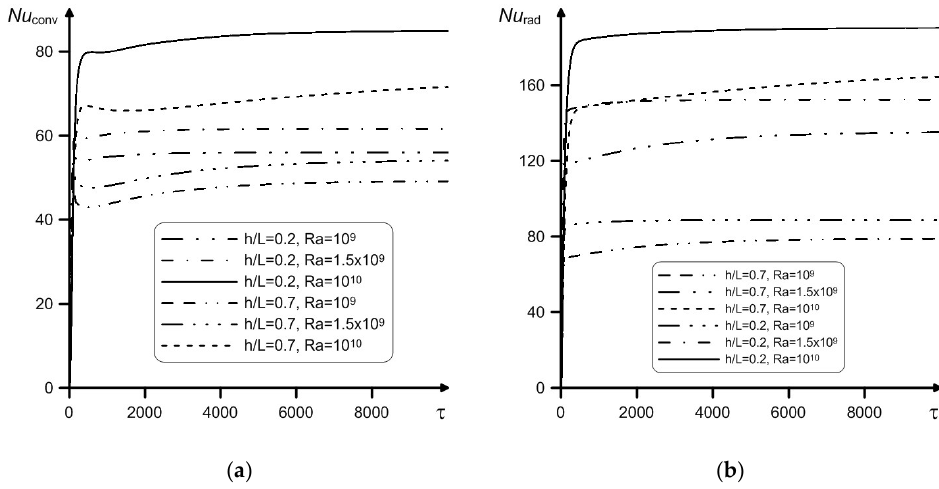
Figure 8. Dependences of the mean convective ( a ) and radiative ( b ) Nusselt numbers at the left border vs. Rayleigh number, heat-conducting partition heights and dimensionless time at (cid:101) ε = 0.9, Pr = 0.7, λ w,air = 10,000.